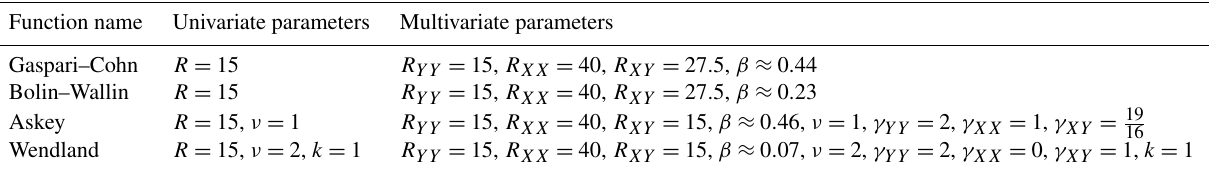
Table B2. Localization parameters for the experiment where we observe both